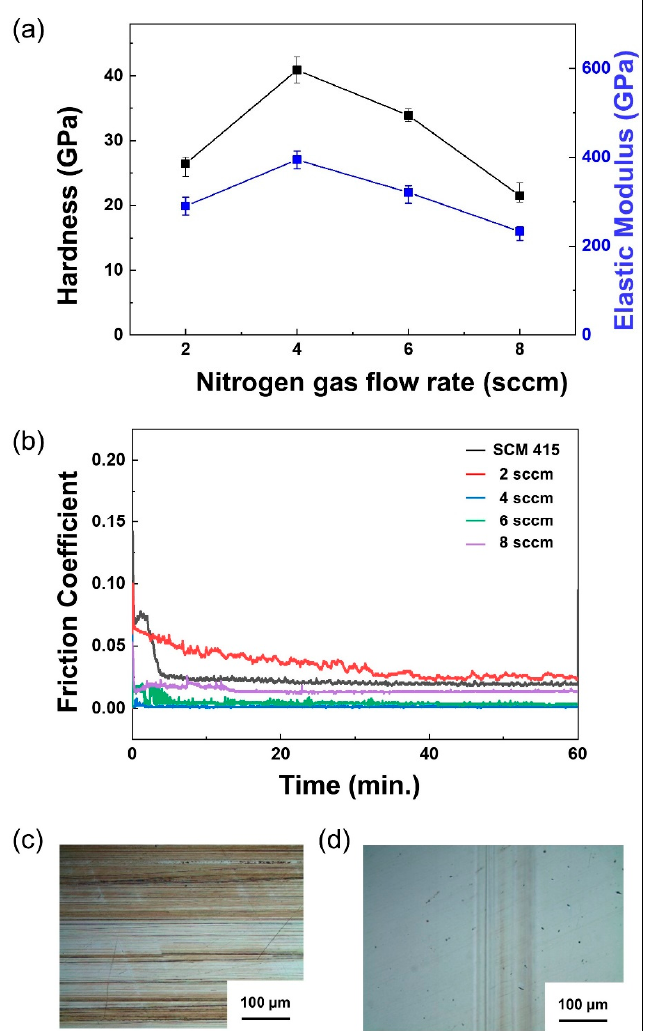
Figure 5. ( a ) Effects of N 2 gas flow on the hardness and elastic modulus of ZrCuSiN at different N 2 gas flow rates. ( b ) Friction coefficient of ZrCuSiN coatings deposited at different N 2 gas flow rates. ( c ), ( d ) Images of the coating surface after the friction test: ( c ) SCM 415, and ( d ) 4 sccm.